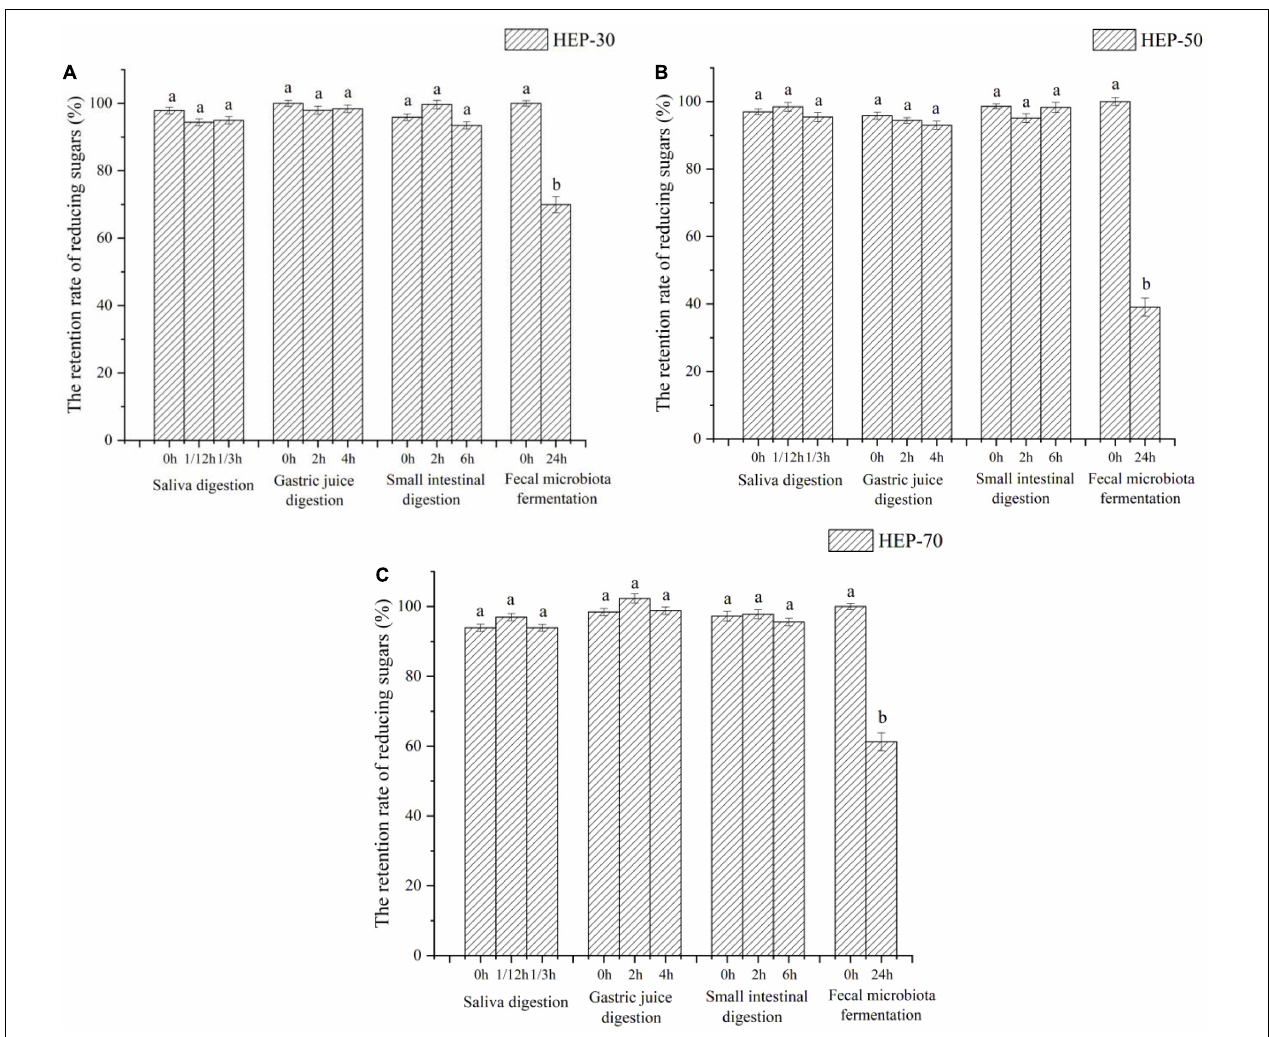
FIGURE 3 | The retention rate of reducing sugars of HEP-30 (A) , HEP-50 (B) , and HEP-70 (C) during the reaction. The retention rate of total carbohydrate = (the content of reducing sugars during the reaction/the content of reducing sugars before the reaction) × 100%; a , b Data are means ± SD (3 independent experiments × 3 replication). Different lowercase letters indicate significant differences ( p < 0.05) between fermentation 0 and 24